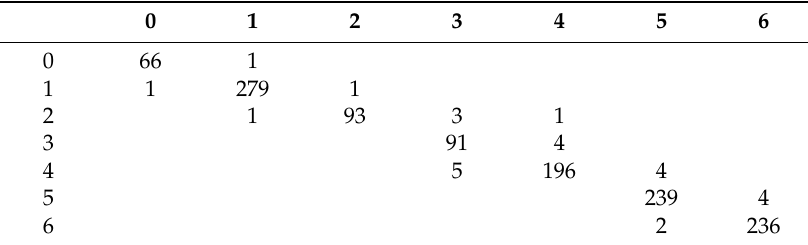
Table A3. The confusion matrix of Figure 9b.